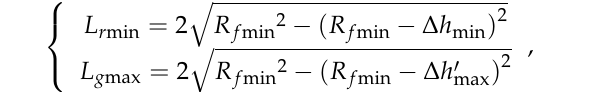
conditions can be calculated using Equation